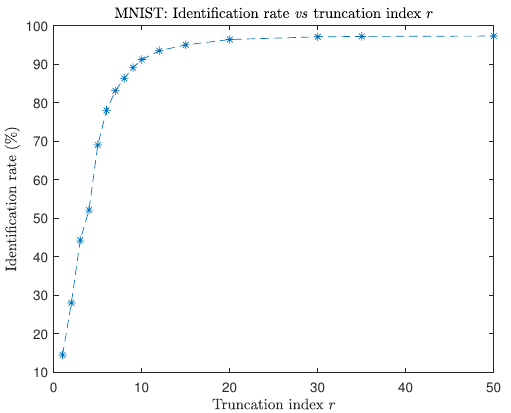
Figure 4. Identification rates for different truncation indices r .